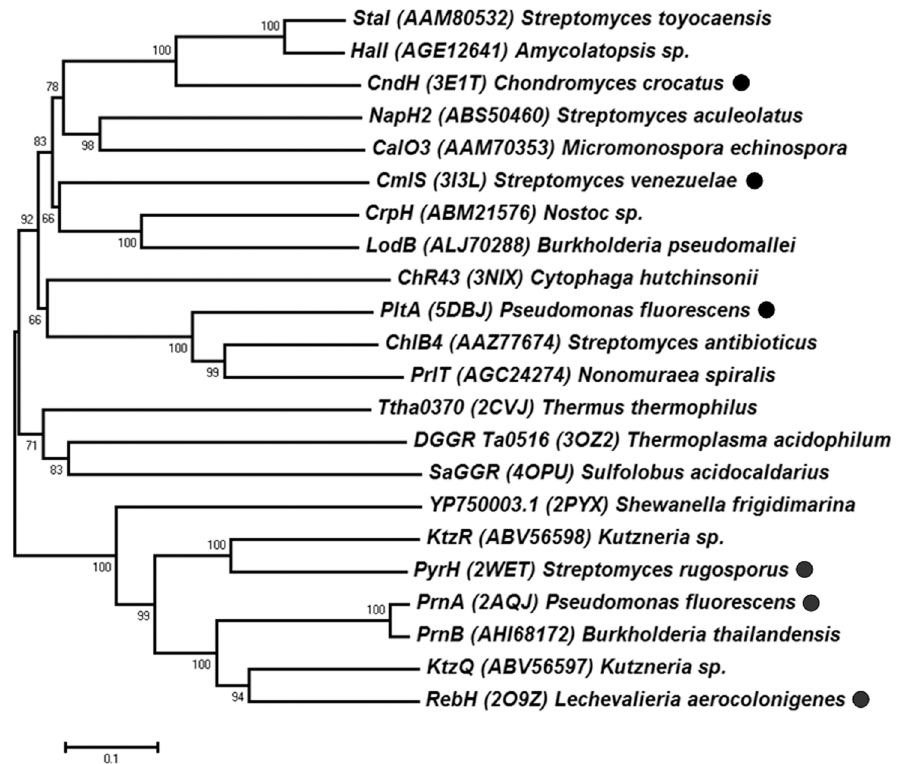
Fig 4. Evolutionary relationships between the F-HG and the oxidoreductases. The phylogenetic tree was reconstructed using the Neighbor-Joining method. The representative F-HG enzymes are marked ( ● ).